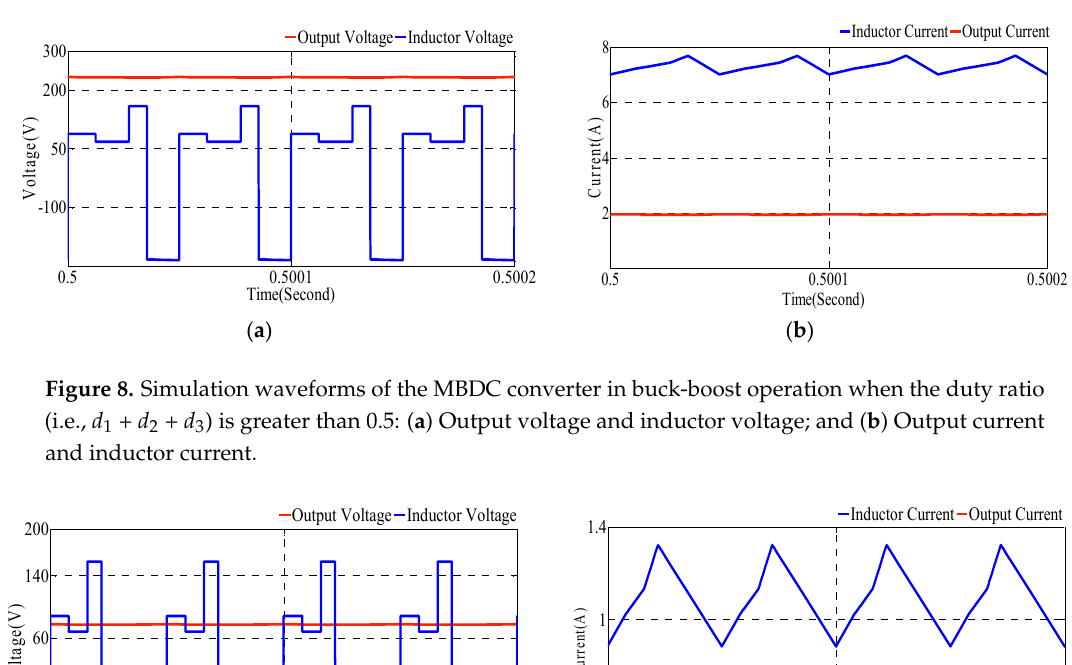
inductor voltage; and ( b ) Output current and inductor current .